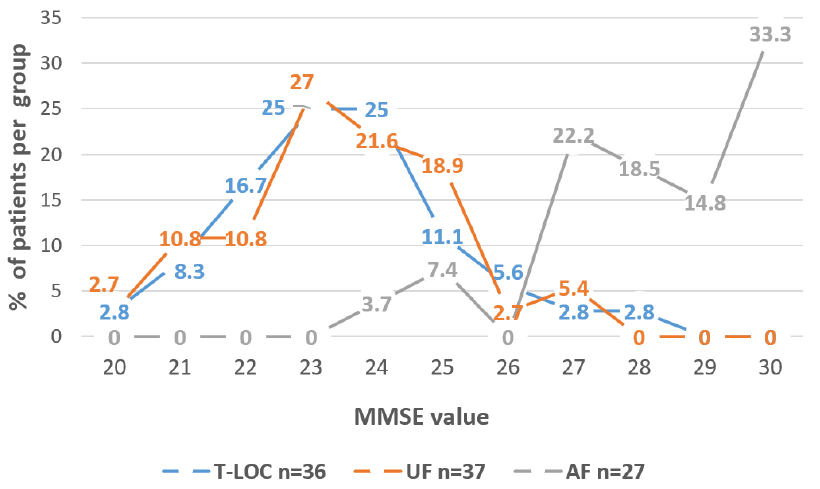
Figure 2. MMSE (range 0–30, where 30 is normal) distribution in T-LOC, UF and AF patients. T-LOC: transient loss of consciousness; UF: unexplained fall; AF: accidental fall.